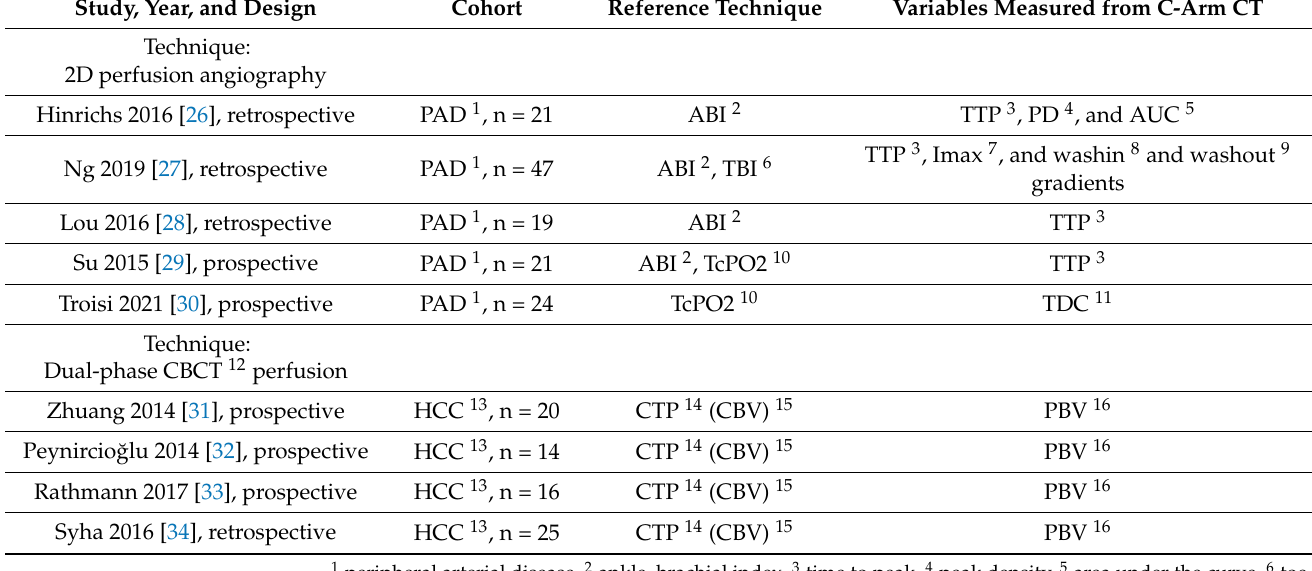
Table 1. Study characteristics and overview of perfusion imaging techniques.